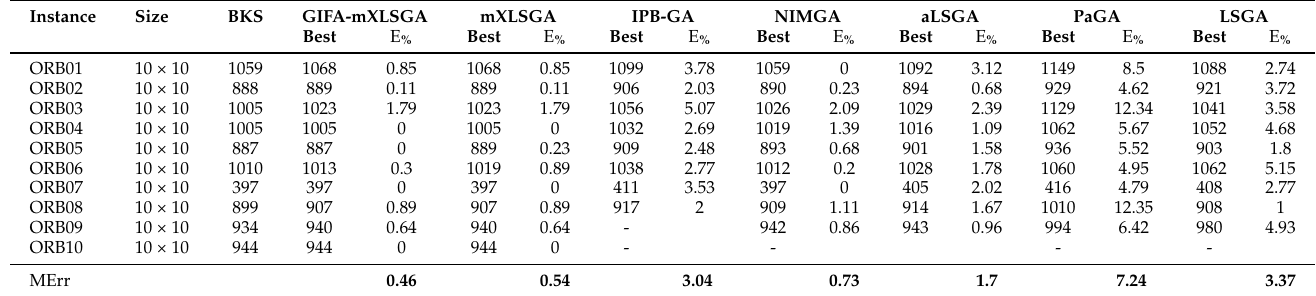
Table 4. Comparison of computational results between GIFA-mXLSGA and other algorithms for ORB. The symbol “-” means “not evaluated in that instance”.